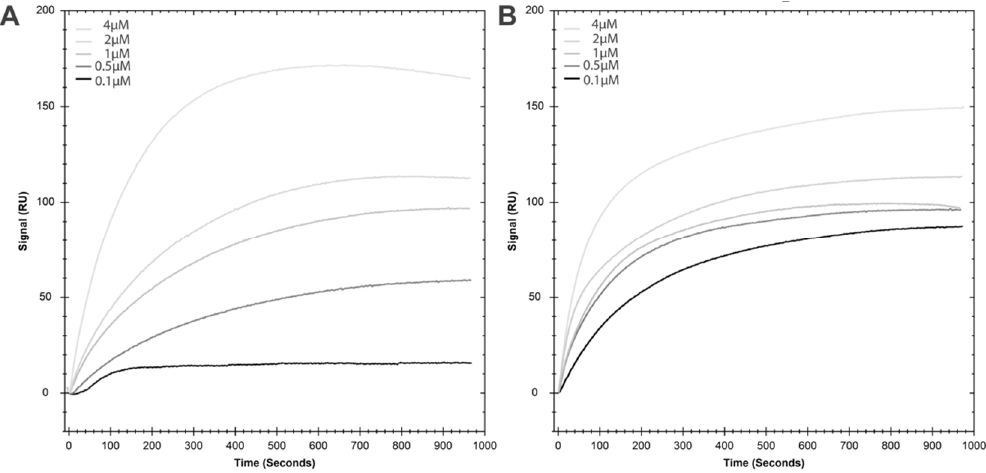
Figure 7. Surface plasmon resonance (SPR) binding measurements of wild-type ( A ) and K71A ( B ) HspA1A with PS-containing vesicles. Increasing concentrations of HspA1A were injected into the Biacore ™ X100 instrument, where flow cell 1 contained POPC (100) vesicles and flow cell 2 contained POPC:POPS (80:20). Flow cell 1 and flow cell 2 response unit (RU) values before protein injections were normalized to zero to present HspA1A binding sensorgrams as shown. Table 1. Kinetic parameters of the HspA1A (WT) and K71A mutant based on the SPR measurements. Protein R max